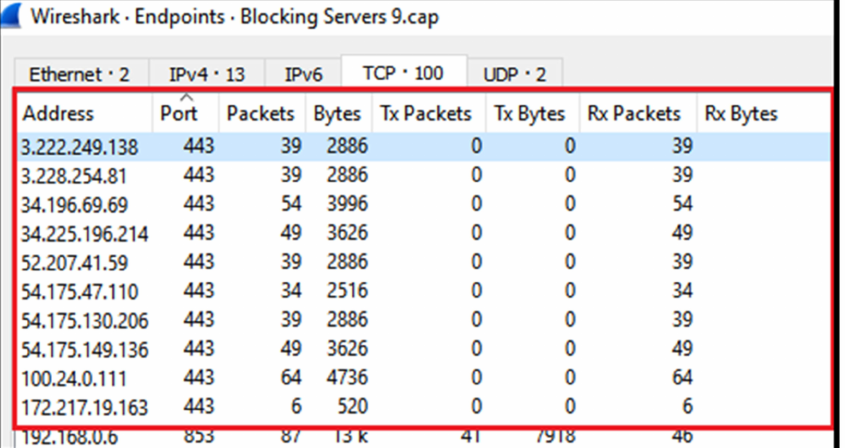
Figure 20. Response from blocked